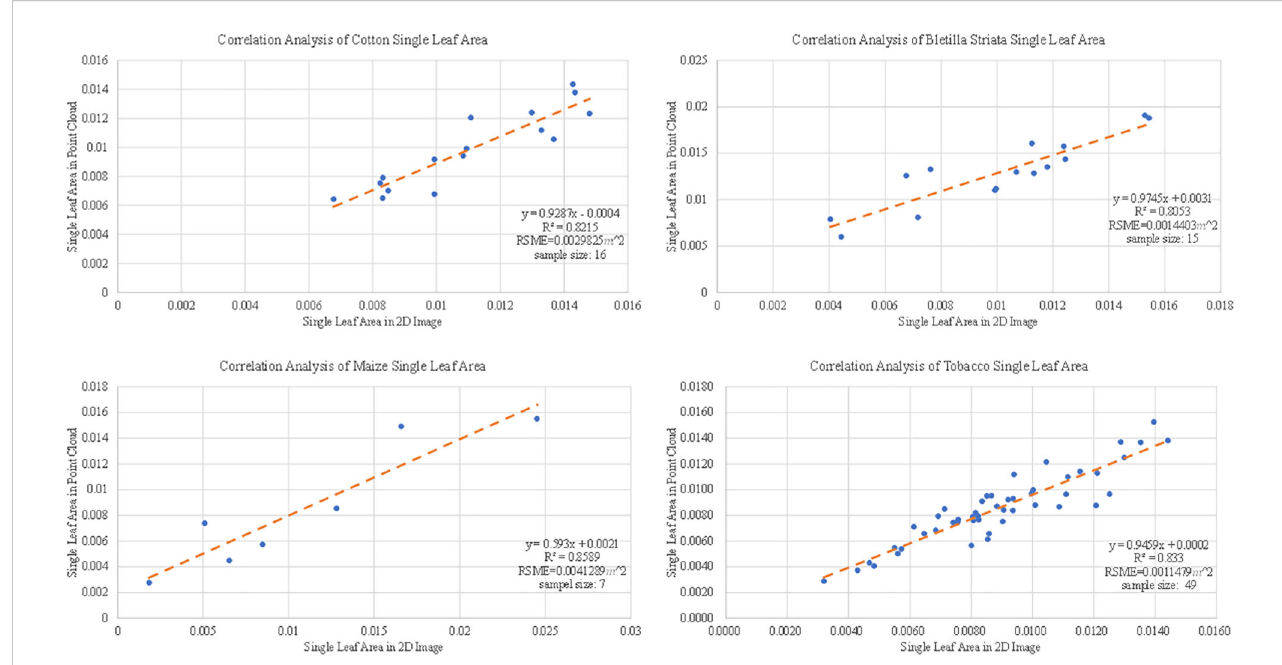
FIGURE 11 Correlation analysis of leaf area of cotton, maize, Bletilla striata and